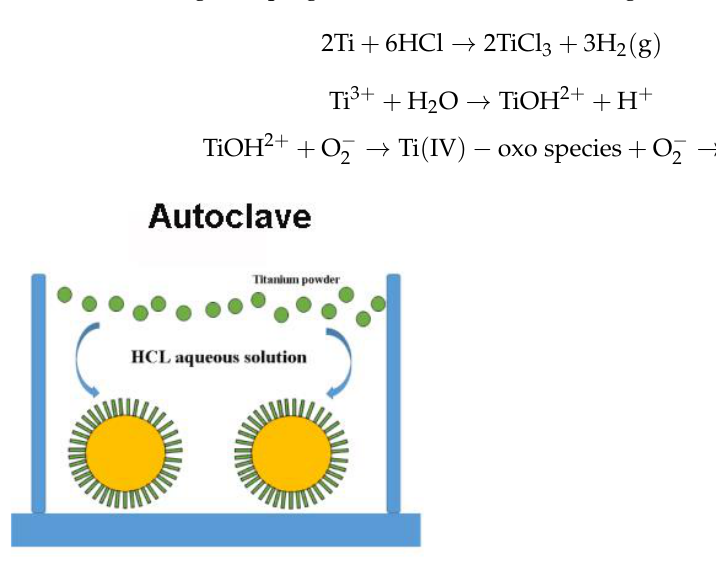
Figure 9. Schematic diagram of the formation mechanism of TiO 2 nanorods.